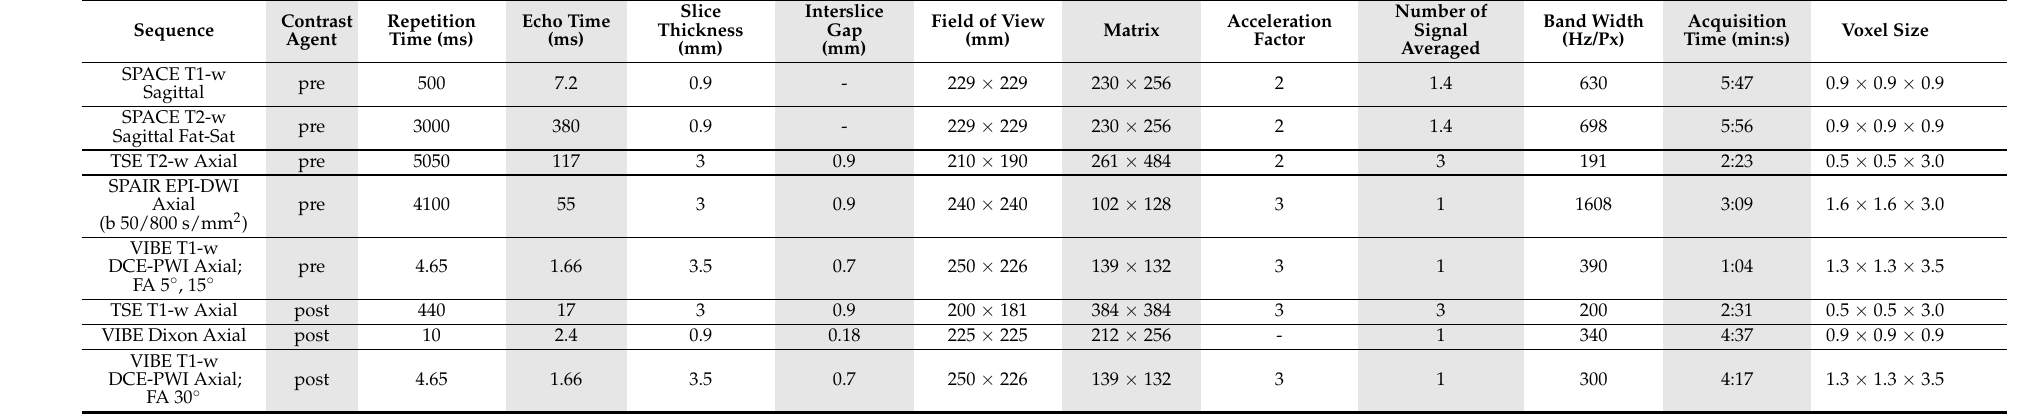
Table A1. MRI acquisition parameters. Unenhanced scans included T1 and T2 sampling perfection with application-optimized contrasts using different flip angle evolution (SPACE) sequences with axial, coronal, and sagittal multiplanar reconstructions; axial T2 turbo spin echo; axial fat-saturated, echo-planar DWI spectral